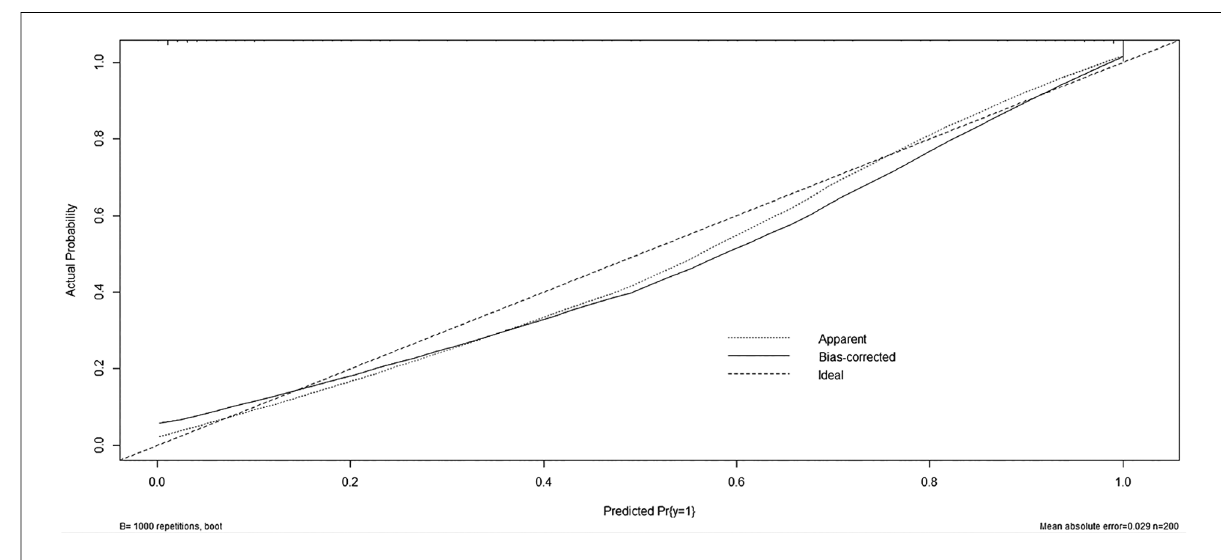
FIGURE 4 Wilson ’ s disease prediction model calibration